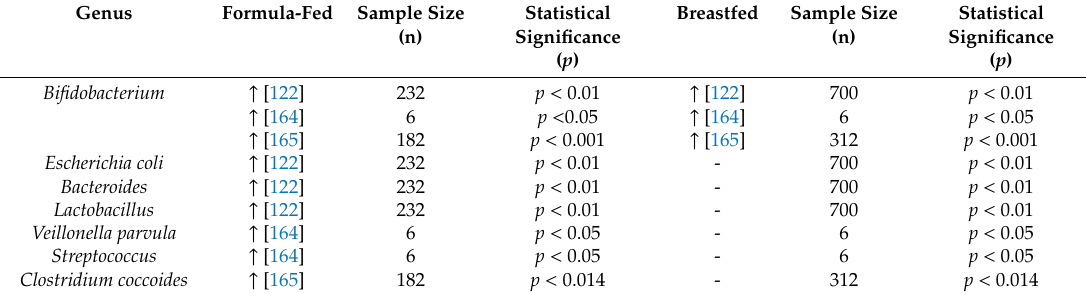
Table 3. Listing the di ff erent genera, predominantly found in formula-fed vs. breastfed infants. The arrow ↑ describes that this genus is increased in variously fed infants, while ‘-‘ represents that there is no significant change in this genus. One can clearly see that microbial diversity is increased in formula-fed in comparison to breastfed infants. p levels less than 0.05 were considered statistically di ff erent. Breastfed Sample Size Genus Formula-Fed Sample Size Statistical (n) Significance